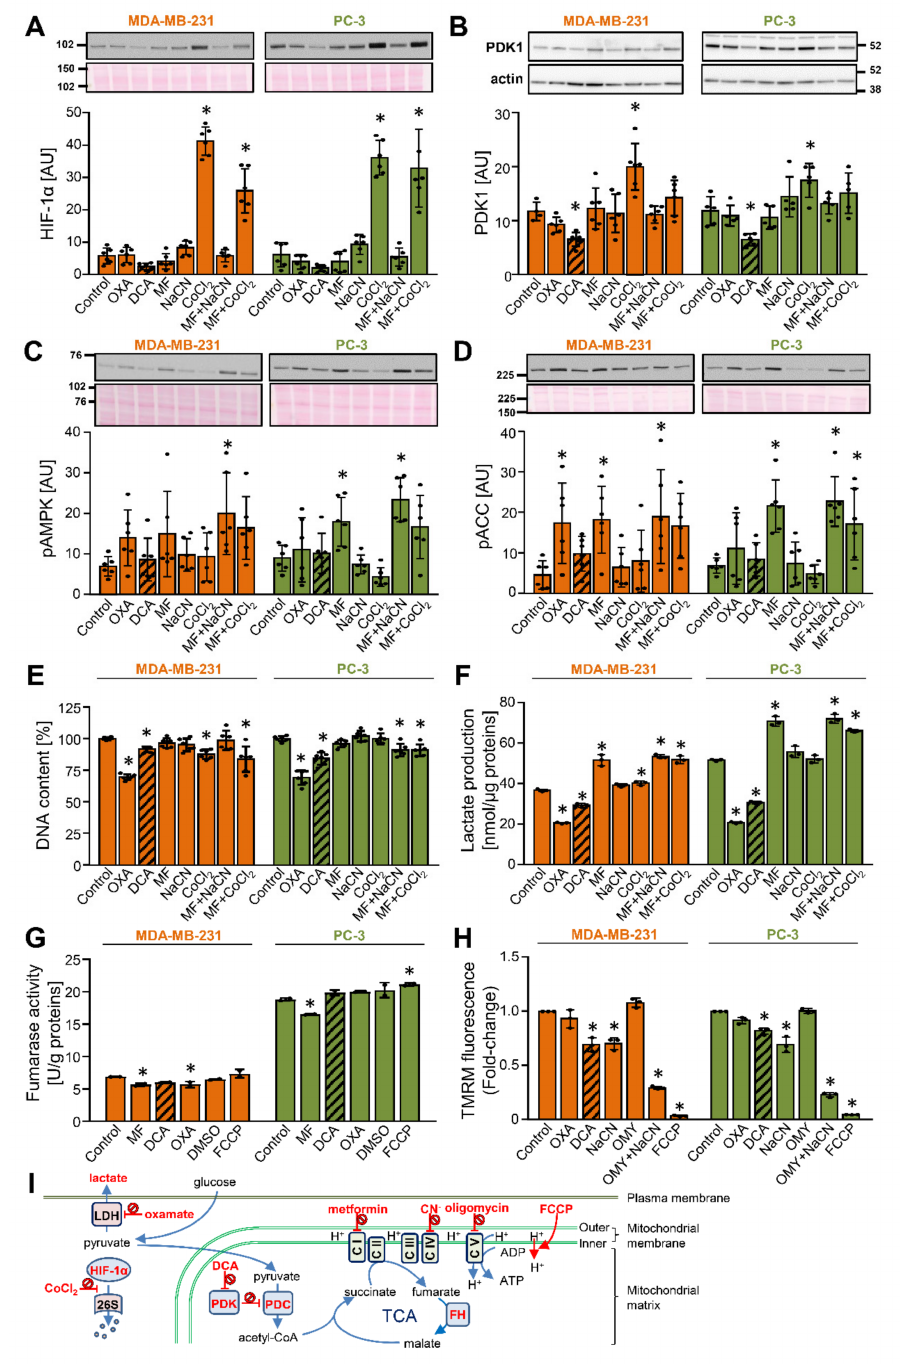
Figure 1. DCA reduces the abundance of PDK1 in MDA-MB-231 and PC-3 cancer cells. ( A – G ) Cells were treated with 10 mM oxamate (OXA), 10 mM DCA, 5 mM metformin (MF), 5 mM NaCN, 250 µ M CoCl 2 , metformin + NaCN or metformin + CoCl 2 , or 0.5 µ M FCCP or dimethyl sulfoxide (DMSO) for 24 h in RPMI medium without FBS ( A – D , F ) or with 10% FBS ( E , G ). Immunoblotting was used to evaluate the protein levels of ( A ) HIF-1 α , ( B ) PDK1 and β -actin, ( C ) phospho-AMPK α Thr172 (pAMPK), and ( D ) phospho-ACC Ser79 (pACC). Total protein loading was evaluated by staining with Ponceau S (shown below the blots). Numbers next to the blots and Ponceau stains indicate molecular weight markers in kDa. ( E ) The total DNA content was estimated by Hoechst 33342 staining. ( A – E ) Results are means ± SD of two experiments in triplicate for each cell line ( n = 6). ( F ) Lactate production in 24 h. Results are means ± SD of one experiment in triplicate ( n = 3). ( G ) Activity of fumarase (fumarate hydratase). Results are means ± SD of one experiment in duplicate ( n = 2). ( H ) MDA-MB-231 and PC-3 cancer cells were treated for 40 min with 10 mM oxamate (OXA), 10 mM DCA, 10 mM NaCN, 5 µ M oligomycin (OMY), OMY + NaCN, or 40 µ M FCCP in PBS with 1 g/L glucose 10 mM HEPES, 2 mM glutamine, and 1% FBS. Mitochondrial membrane potential was determined using TMRM. Results are means ± SD of three independent experiments ( n = 3). ( I ) Site of action of compounds used in these experiments. Abbreviations: CI–V: mitochondrial complexes I–V, FH: fumarate hydratase (fumarase), PDC: pyruvate dehydrogenase complex, PDK: pyruvate dehydrogenase kinase, LDH: lactate dehydrogenase, 26S: the 26S proteasome, OMY: oligomycin; TCA: the tricarboxylic acid (Krebs) cycle. * p < 0.05 vs.